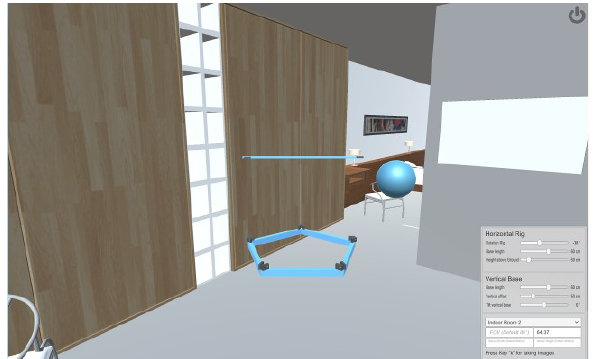
Figure 5. Camera rig with a blue sphere in the background, indicating a possible location for the camera